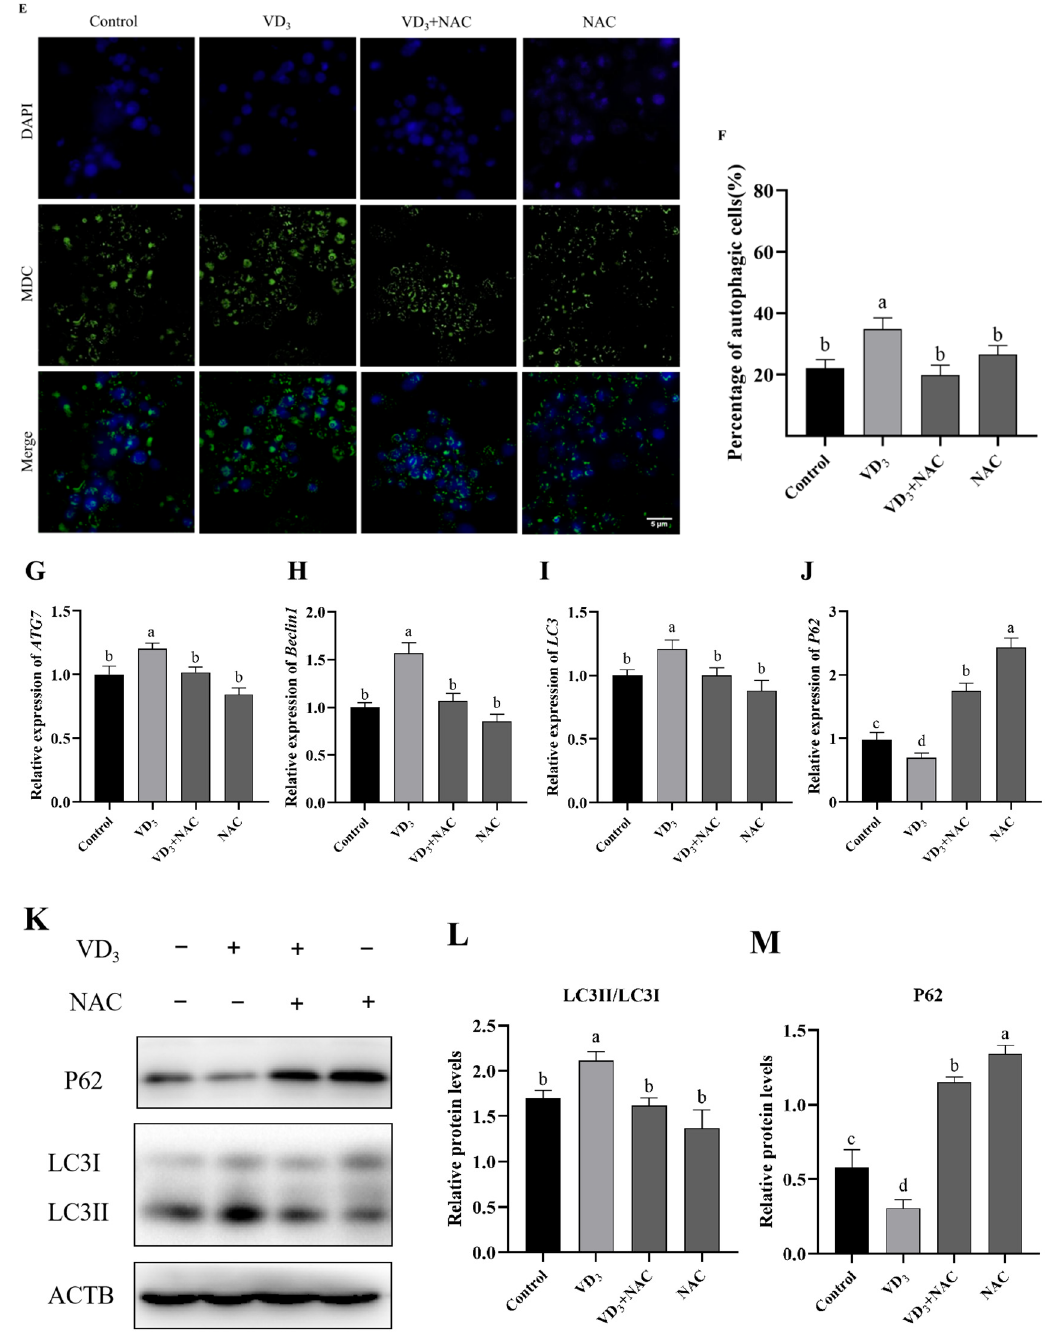
Figure 6. 1 α ,25(OH) 2 D 3 ‐ induced ROS promotes autophagy in PGCs. ( A ) The relative viability of PGCs treated with the different doses of NAC in the presence/absence of 1 α ,25(OH) 2 D 3 for 24 h. The intracellular ROS was measured by a multifunctional microplate reader ( B ) and fluorescence microscope ( C ), and the ROS content was evaluated ( D ). MDC ‐ labeled autophagic vacuoles in PGCs ( E ). The fluorescence intensity of autophagic vacuoles was evaluated ( F ). The relative gene expression of ATG7 ( G ), Beclin1 ( H ), LC3 ( I ), and P62 ( J ) in PGCs. Western blotting was used to identify the protein level ( K ), and the protein contents of LC3II/I ( L ) and P62 ( M ) were evaluated in PGCs. Bar = 5 μ m. VD 3 : 1 α ,25(OH) 2 D 3 . NAC: N ‐ acetylcysteine. Different letters on the bar indicate a significant difference. Data are means ± SE of three independent replicates ( p < 0.05).